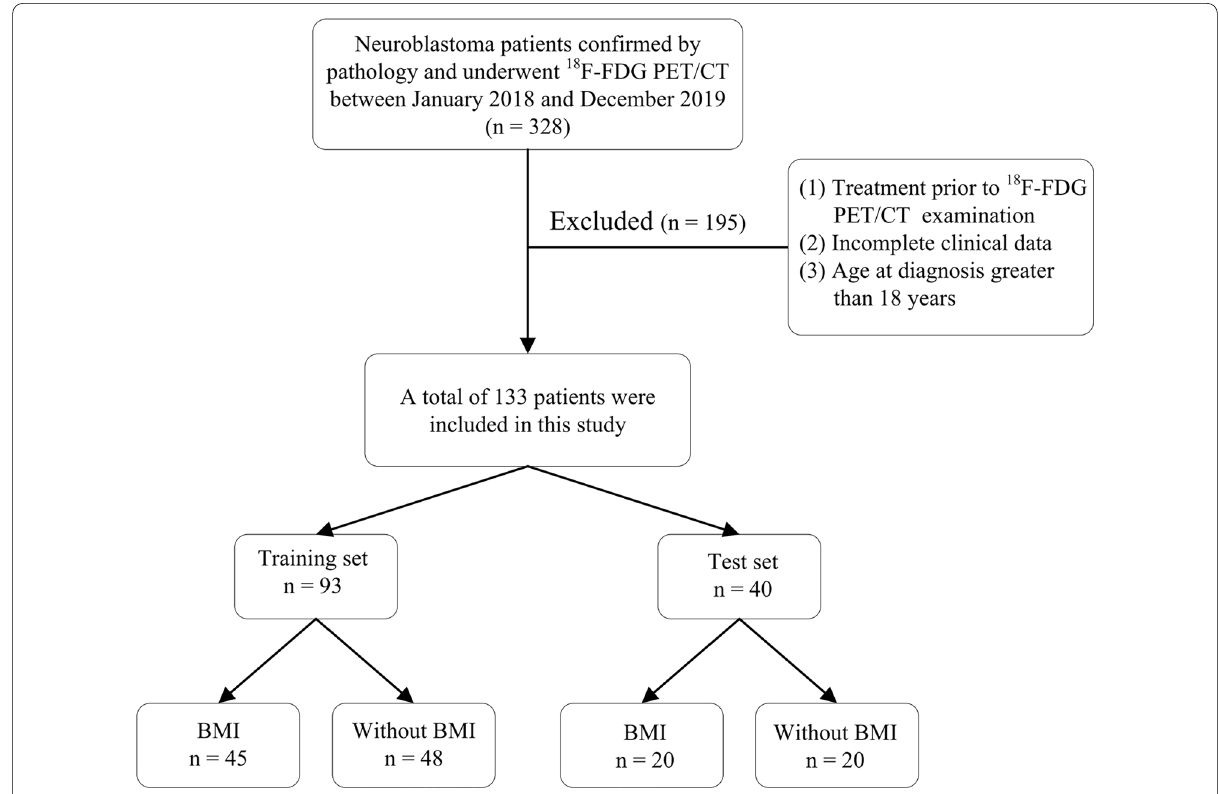
Fig. 1 The flow chart for patient